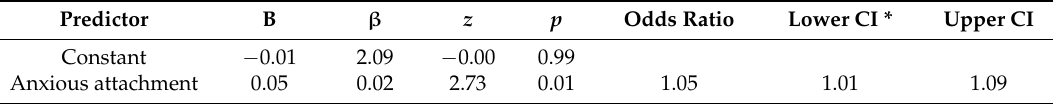
Table 2. Significant predictors of quality of life scores using a backwards stepwise regression analysis. Predictor B